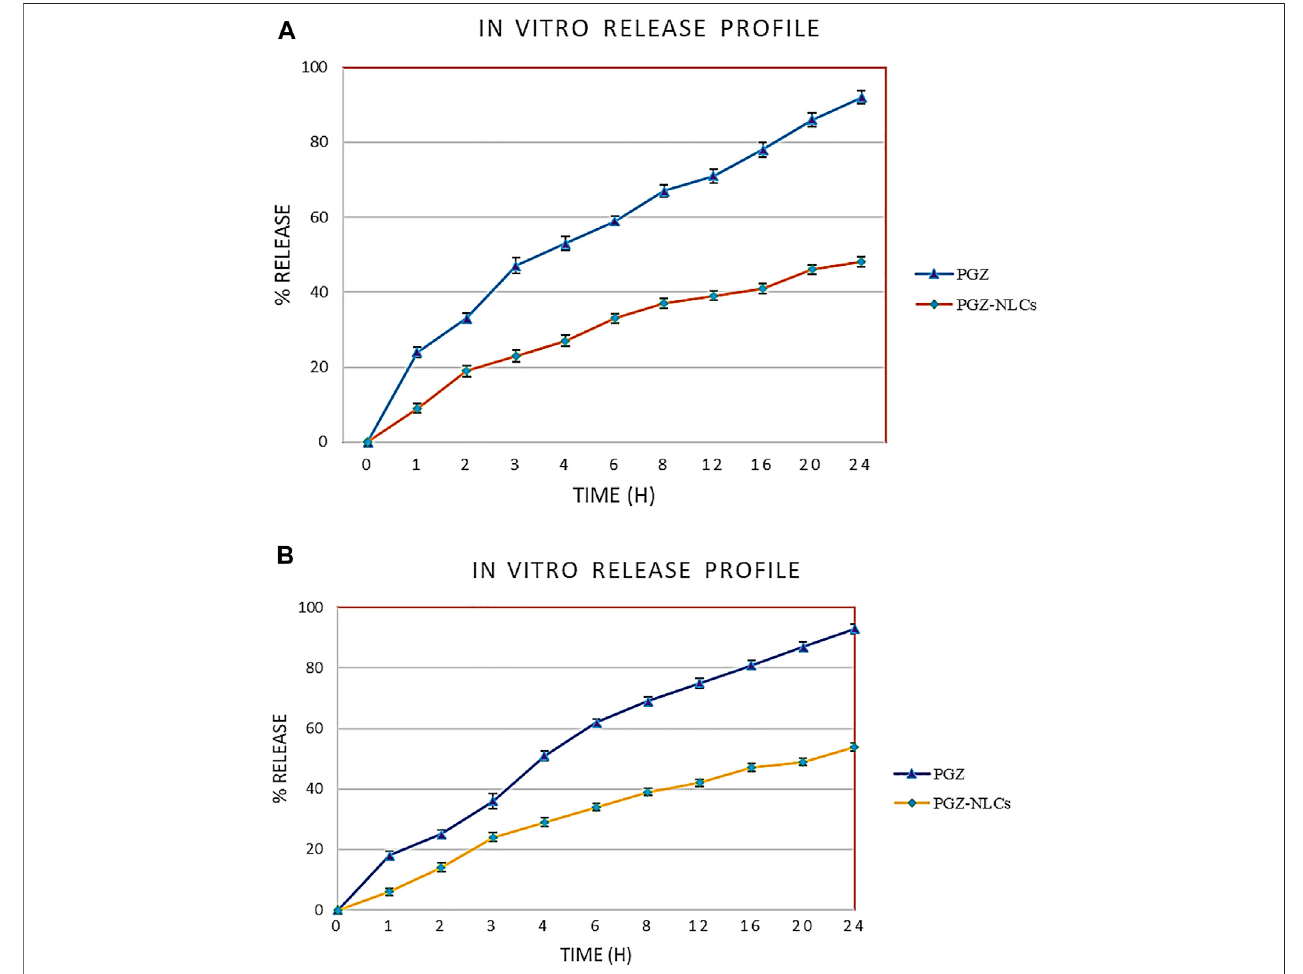
FIGURE 6 | (A) Comparative pro fi les of in vitro release of unformulated PGZ and PGZ-NLCs in simulated gastric fl uid. (B) Comparative pro fi les of in vitro release of unformulated PGZ and PGZ-NLCs in simulated intestinal fl uid.